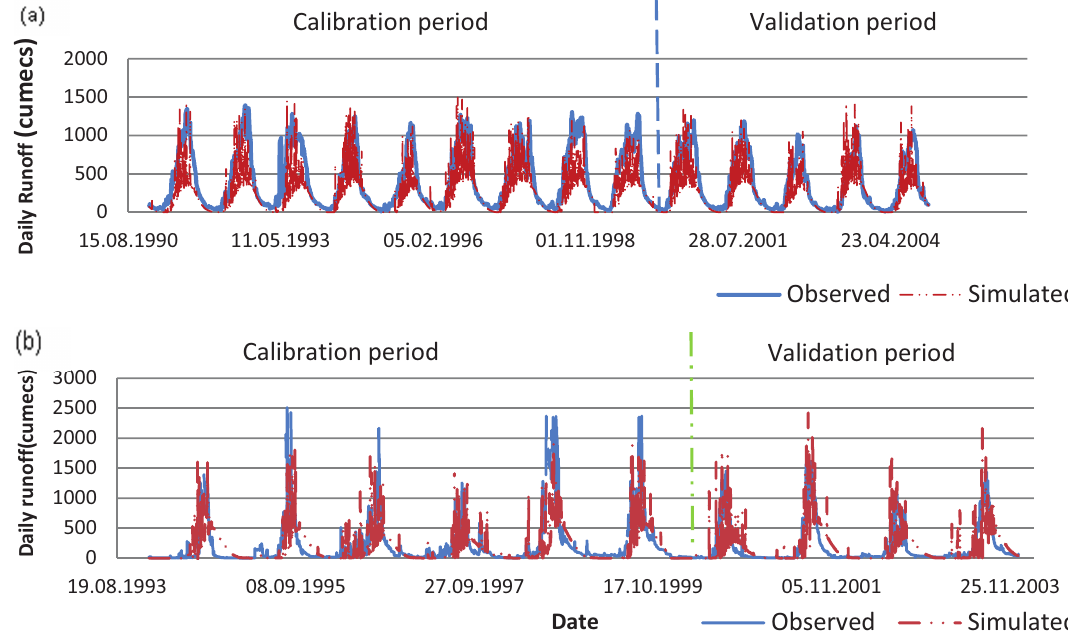
Fig. 6. Daily observed (blue) and simulated (red) streamflow during the calibration and validation periods for the (a) Baro Akobo at Gambella and (b) Tekeze at Embamadre.